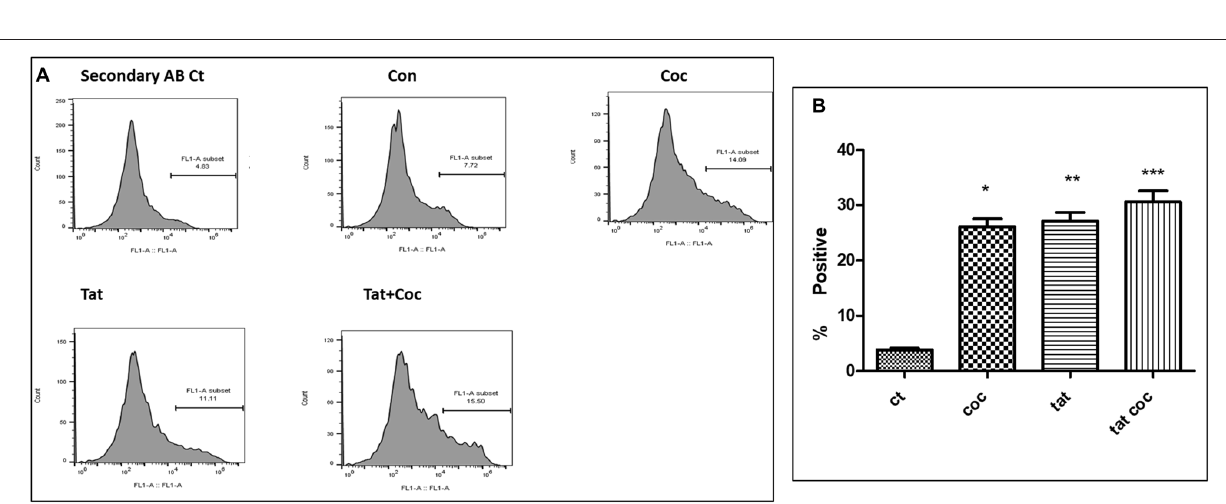
and coc (0.1 µ M) were used for further WA neutralizing efficacy studies from here